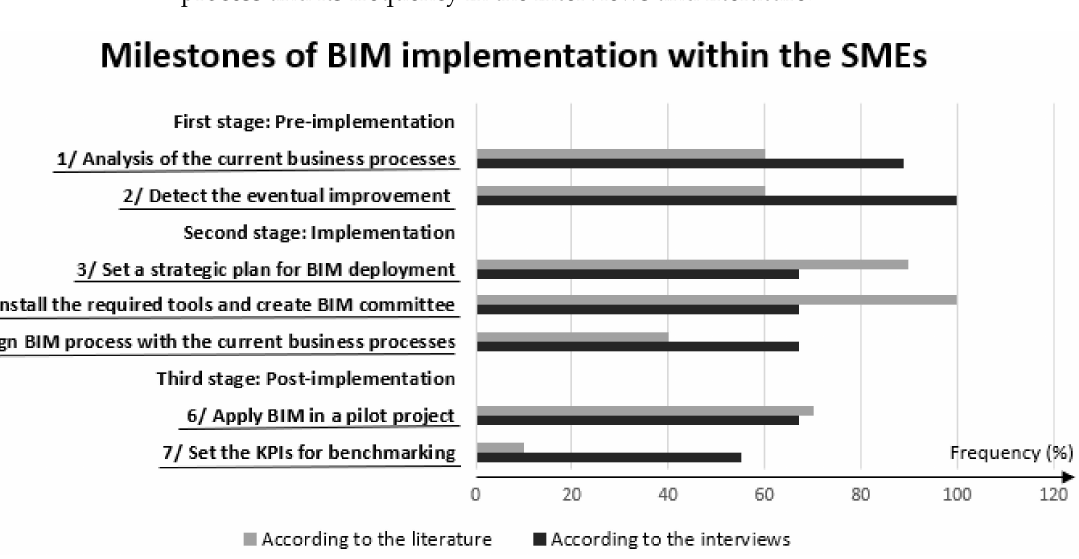
Figure 2. BIM implementation process at the organization